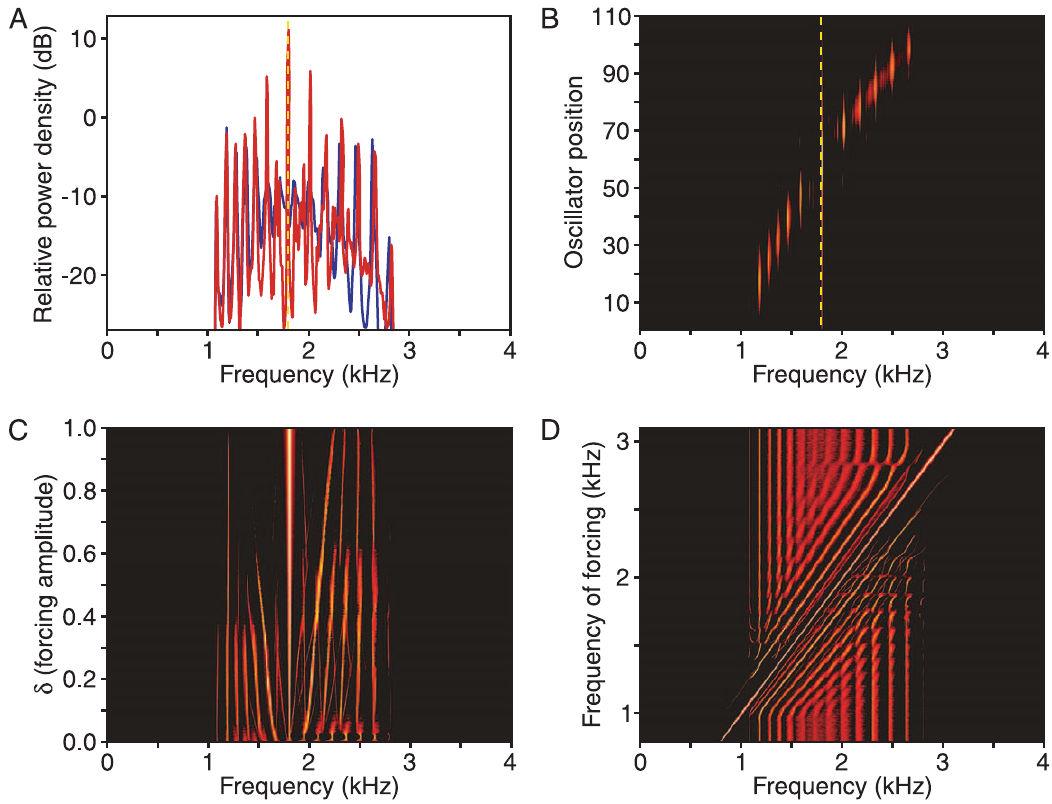
Figure 6. The effect of external stimulation. A. A simulated power spectrum in the absence of stimulation displays relatively weak peaks in its central region (blue trace). The introduction of sinusoidal forcing at a frequency of 1.8 kHz (dashed yellow line) accentuates the central peaks and shifts their frequencies away from that of the stimulus (red trace). The baseline power density immediately surrounding the stimulus frequency is also suppressed; in this instance, the power falls by an average of 12 dB within the 30-Hz-wide band immediately adjacent to the stimulus. B. In the presence of stimulation at 1.8 kHz (dashed yellow line), the power spectra for individual oscillators display sharply defined groups near the frequency of forcing. C. As the forcing amplitude d increases from the bottom of the figure toward the top, vertically layered power spectra reveal the systematic migration of the oscillation frequencies of other groups away from that of the stimulus of 1.8 kHz. D. As the external stimulus frequency is varied over a wide range, as denoted by the line running diagonally from the lower left to the upper right, vertically layered power spectra demonstrate the reorganization of successive groups of oscillators. As the stimulus frequency shifts toward higher values, oscillating groups of higher frequency abruptly disappear one by one, whereas additional lower-frequency groups appear.